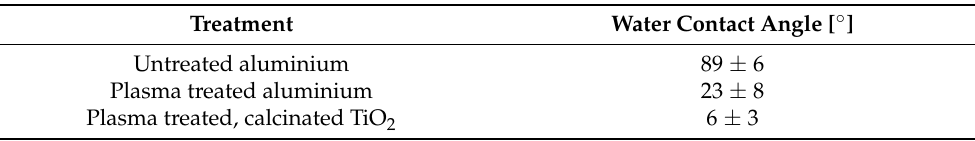
Figure 7. Normalised and stacked Raman microscope spectrum of the substrates with TTIP, TTIP dried for 24 h under ambient conditions and TTIP calcinated at 600 ◦ C for 5 h. Raman spectra were collected with a 488 nm laser with 40 mW, 1 s integration time and 5 co-additions and focused with a 100 × objective. Table 1. WCA measurements of the different types of